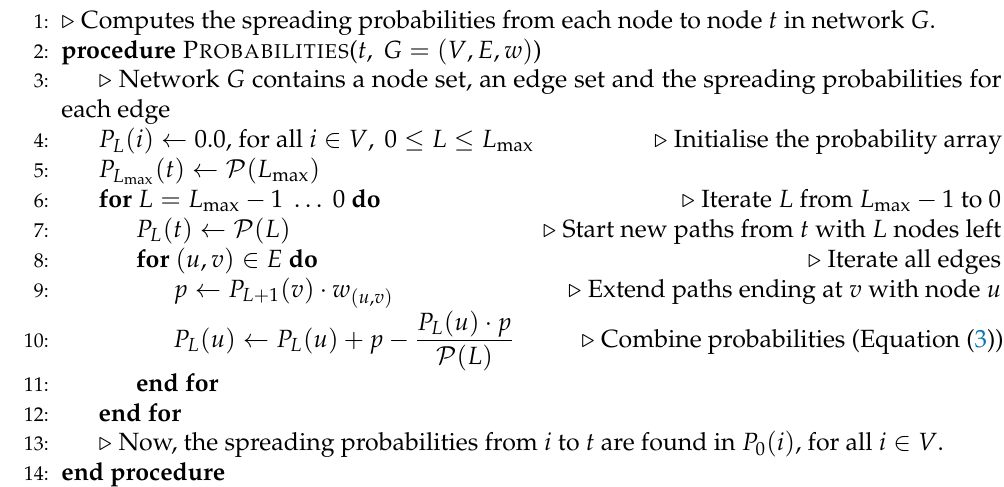
Algorithm 2 The Complex Contagion algorithm